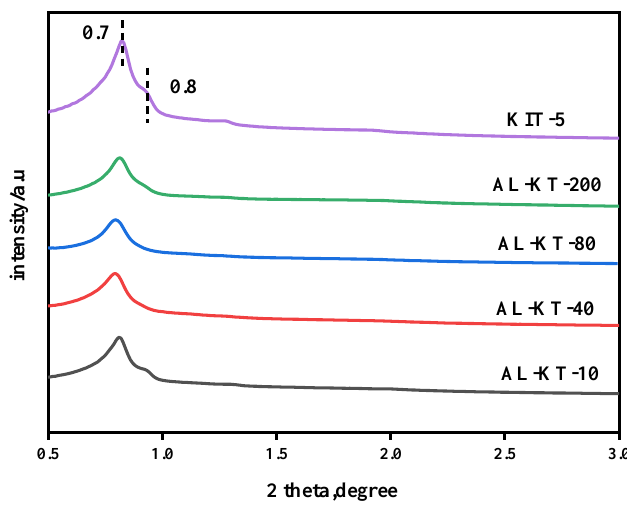
Figure 1. Small-angle X-ray diffraction (XRD) patterns of Al-KT-X and KIT-5 materials.